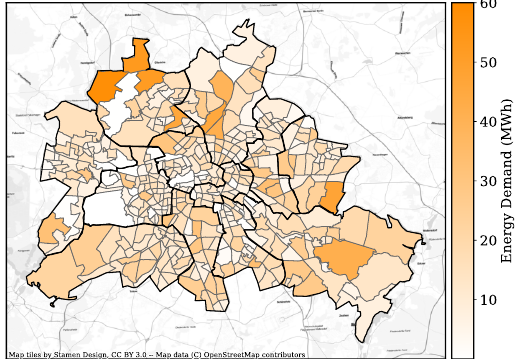
Figure 11. Spatial distribution of the battery electric vehicle (BEV) charging energy demand in the Berlin LORs for a working day